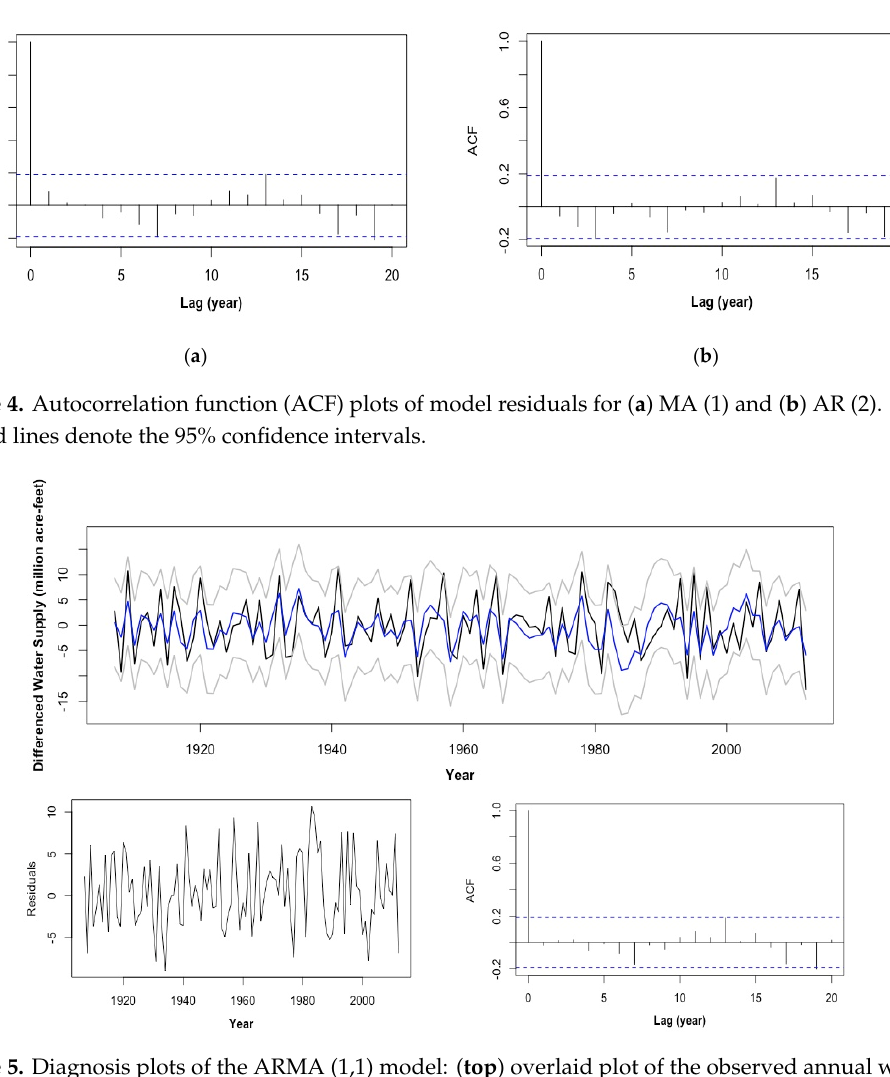
Figure 3. The cross-autocorrelation function (CACF) of the differenced Colorado River and Great Salt Lake (GSL) series. Note the significant cross-autocorrelation at lag − 1. The two blue dashed lines denote the 95% confidence interval.